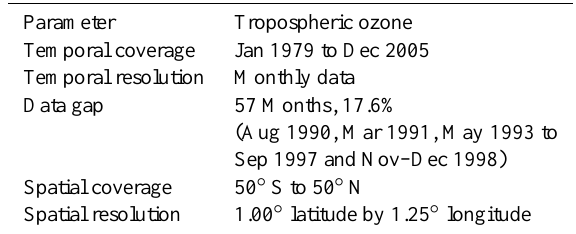
Table 1. Characteristics of Tropospheric Ozone Residual (TOR)